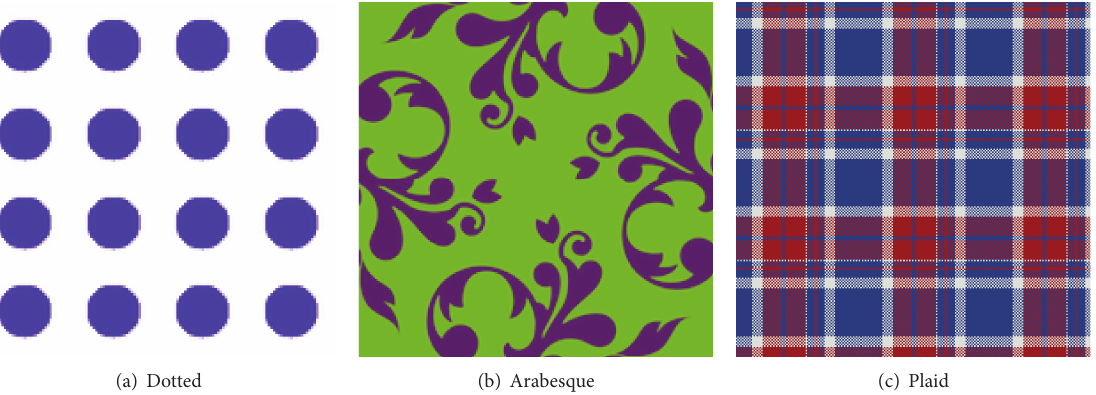
Figure 12: Examples of solutions displayed to users.